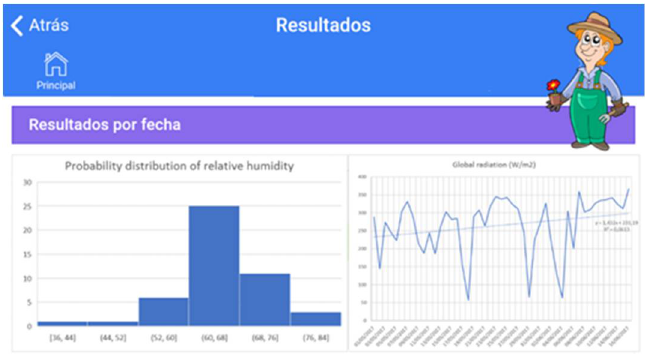
Figure 6. MyShoolGardenApp user